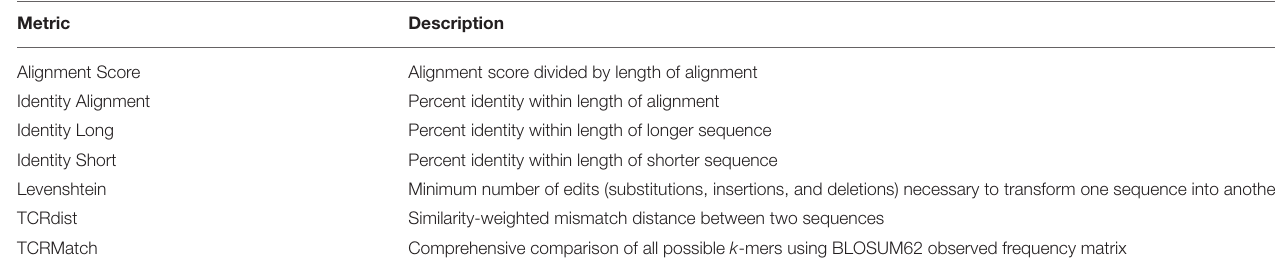
TABLE 1 | Description of the scoring metrics used to identify receptors with identical epitopes.